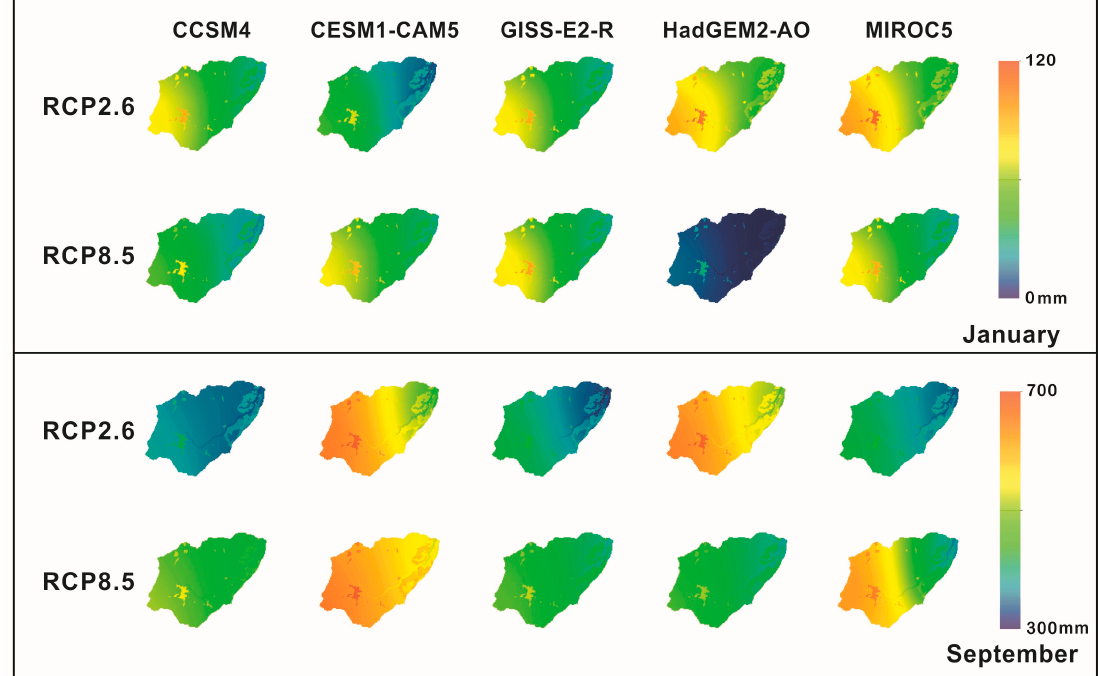
Figure 3. The monthly water yield under different climate change scenarios ( a ) RCP2.6 and ( b ) RCP8.5.